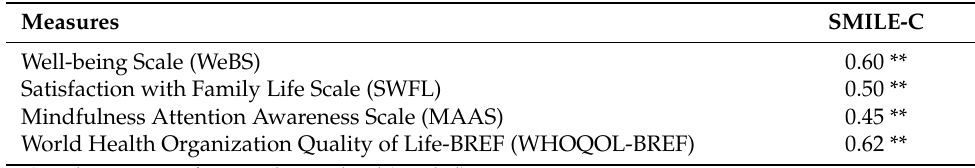
Table 3. Criterion-related validity between SMILE-C and other measures.